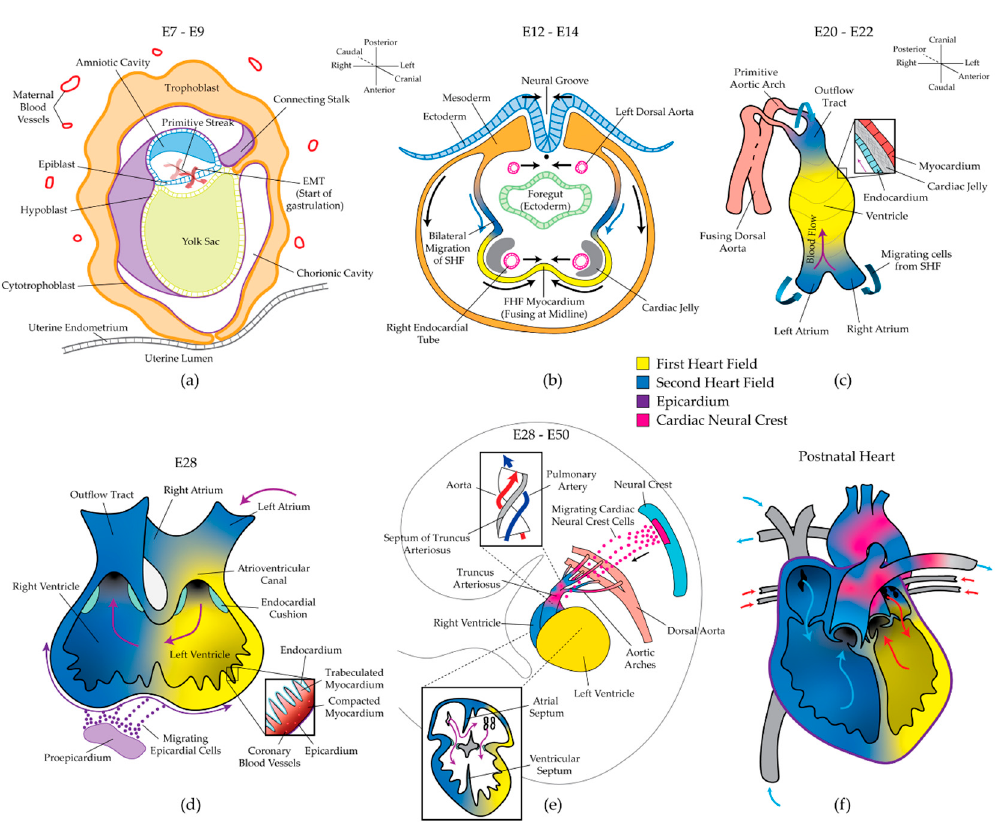
Figure 1. Human heart development. ( a ) The implanted blastocyst quickly forms the bilaminar embryo. The primitive streak forms in the epiblast, and an epithelial-to-mesenchymal transition (EMT) near the streak causes gastrulation to begin. ( b ) Bilateral migration of the first heart field (FHF) and second heart field (SHF) yields the cardiac crescent and endocardial tubes. ( c ) The bilateral cardiogenic regions fuse to form the bilaminar linear heart tube. SHF cells migrate into the poles, and the primitive outflow tract (OFT) begins to fuse with the dorsal aorta. ( d ) Asymmetry is broken with leftward cardiac looping. The proepicardium undergoes EMT to form the epicardium. Inset: trabeculation, compaction, and formation of the primitive coronary vasculature. ( e ) Neural crest cells migrate to populate the OFTs. Insets: Septa separate the truncus arteriosus and the left and right heart; the endocardial cushions give rise to the four valves. ( f ) The postnatal human heart.